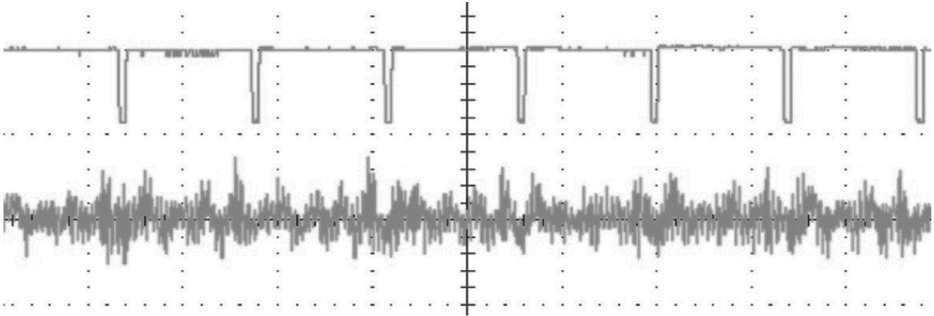
Figure 8. Time waveforms of the signals: upper run—waveform of the compressor shaft marker; bottom run—torsional vibration acceleration of the piston compressor free end.